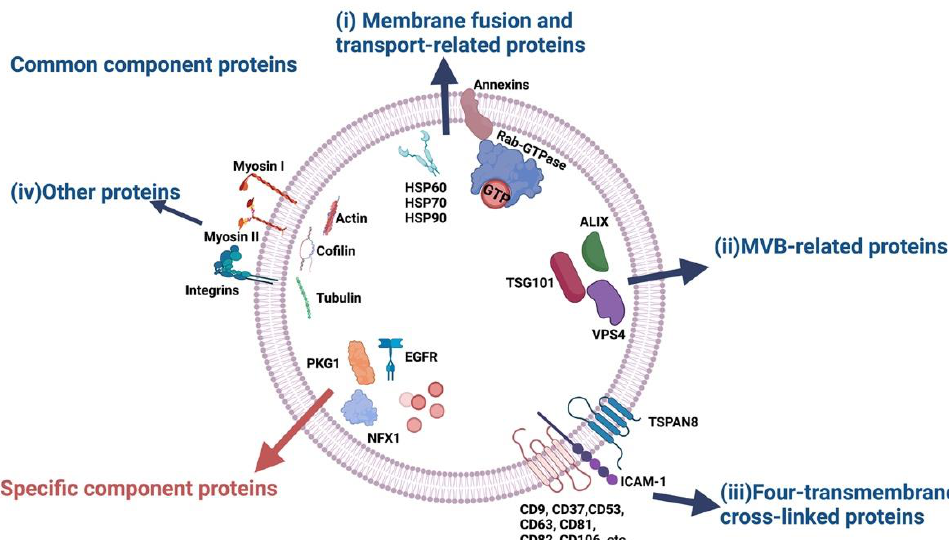
such as cytoskeletal construction [19,20].